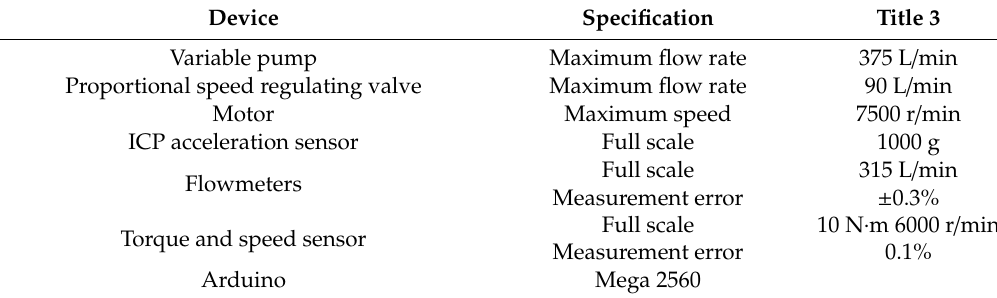
semi. -EXP Figure 40. Vibration waveforms of different orifice shapes (MSE rec. = 9.21 × 10 −4 , MSE tri. = 8.67 × 10 −4 , MSE tri. = 2.71 × 10 −4 ).